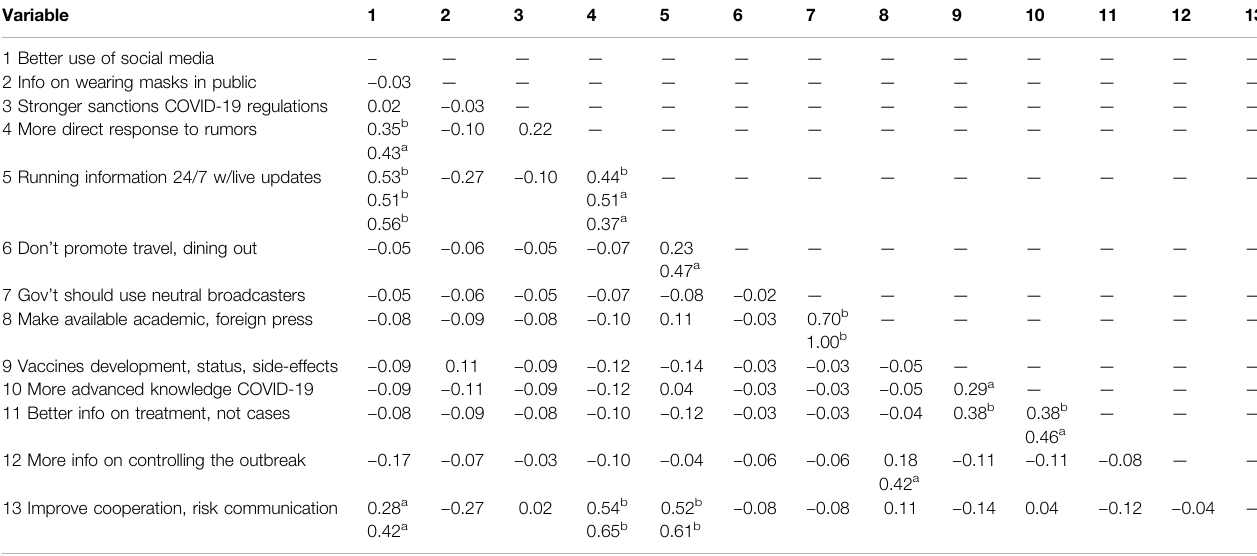
TABLE 9 | Combined RoK and Vietnam correlations on improving the government response to COVID-19, citizen recommendations.